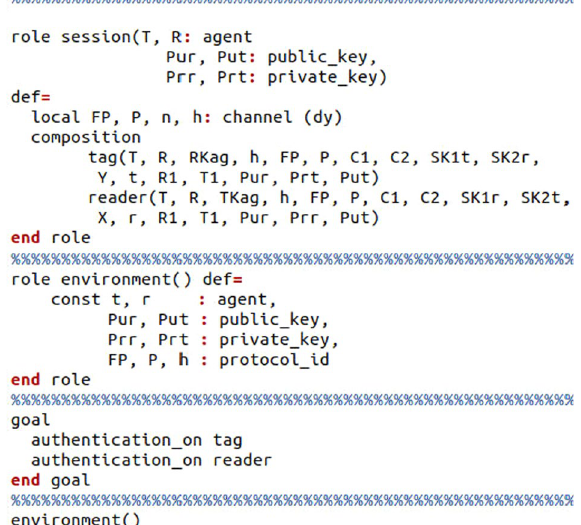
Fig. 7 The characteristics of the roles and the working session between card and card reader for